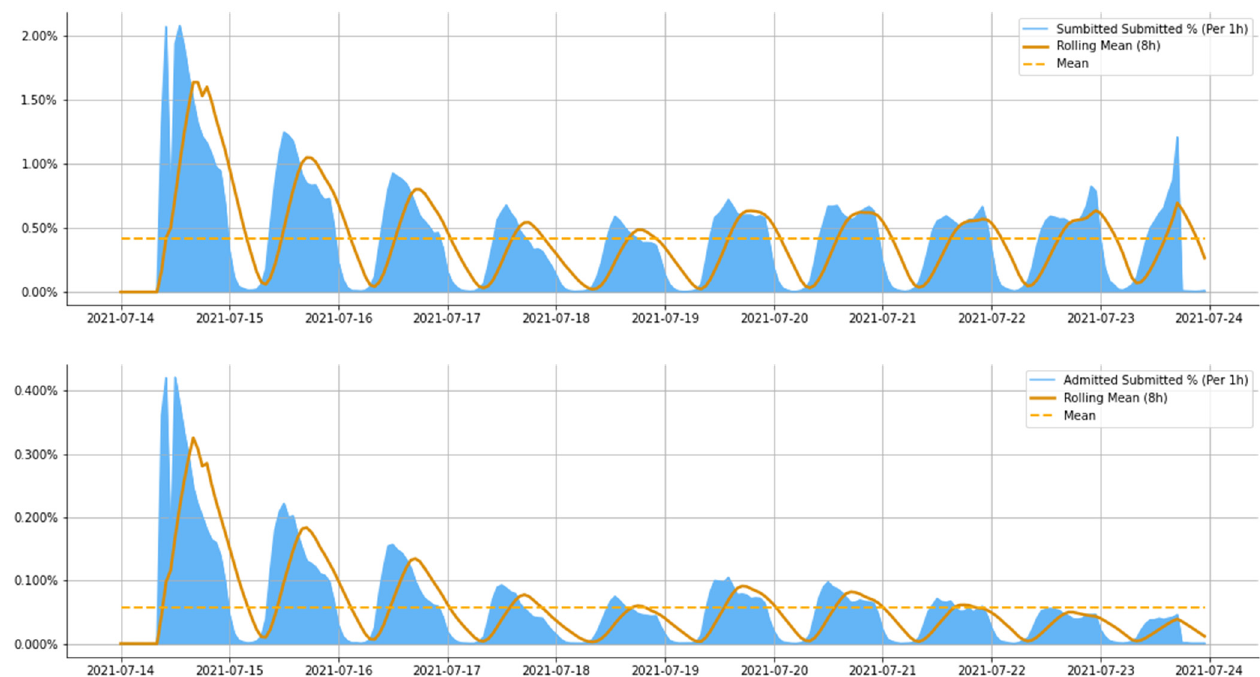
Figure 6. Application submitted/admitted percentage per hour during the entrance campaign.